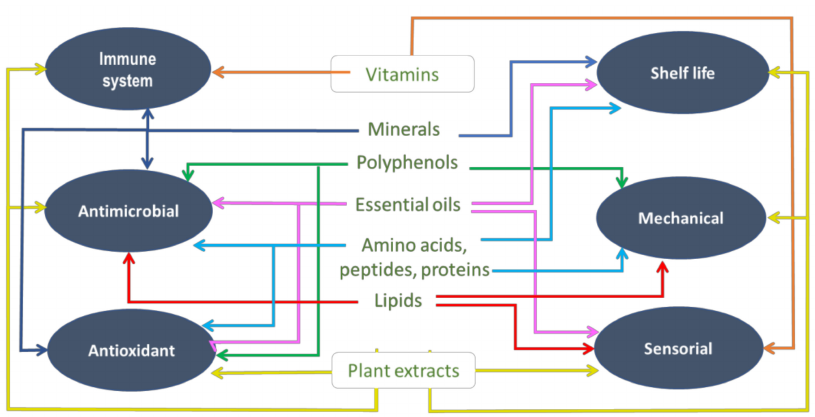
Figure 4. Overview on the main actions of starch-based packaging incorporating bioactive com- pounds and plant extracts for sustaining consumers’ health and safety ( left ) and the packaged products ( right ) (original drawing by the